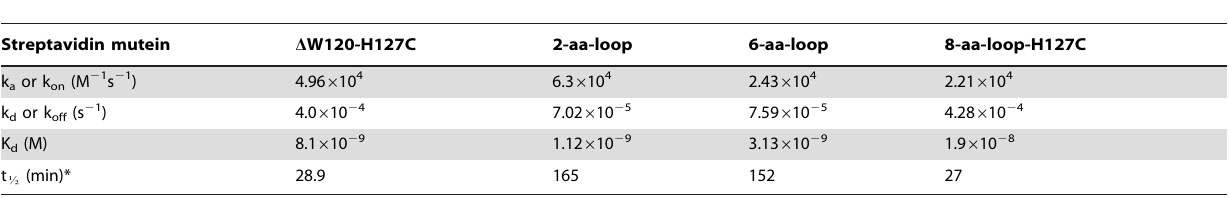
Table 2. Kinetic parameters of biotin binding in streptavidin